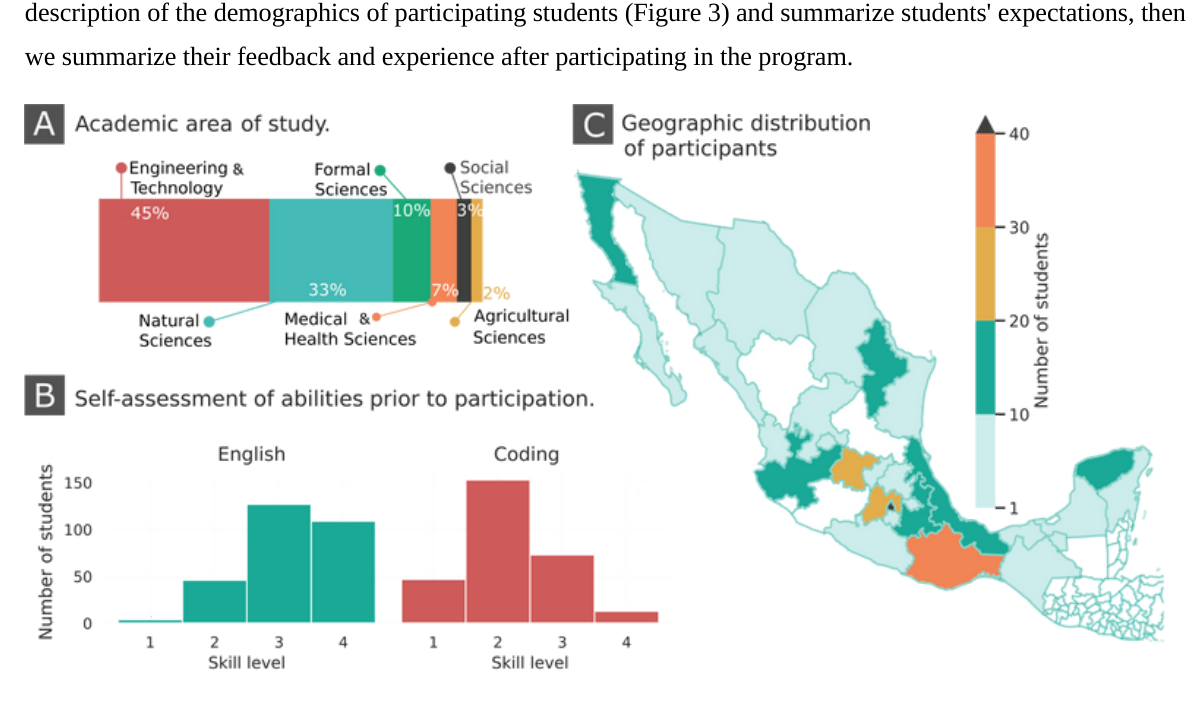
Figure 3. A snapshot of students that participated in our 2020 program. A) Barplot of the area of study of students. B) Barplot of English and programming skills prior to the Clubes de Ciencia Mexico (CdeCMx) Challenge—levels are defined as null (1), basic (2), intermediate (3), and advanced (4). C) Map of the states of Mexico color-coded by the number of participating students in each